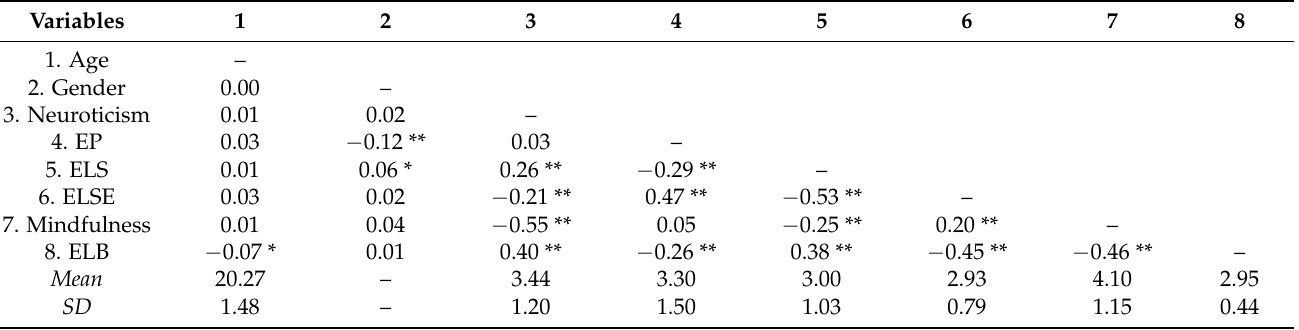
Table 1. Means, standard deviations, and correlation coefficients for all